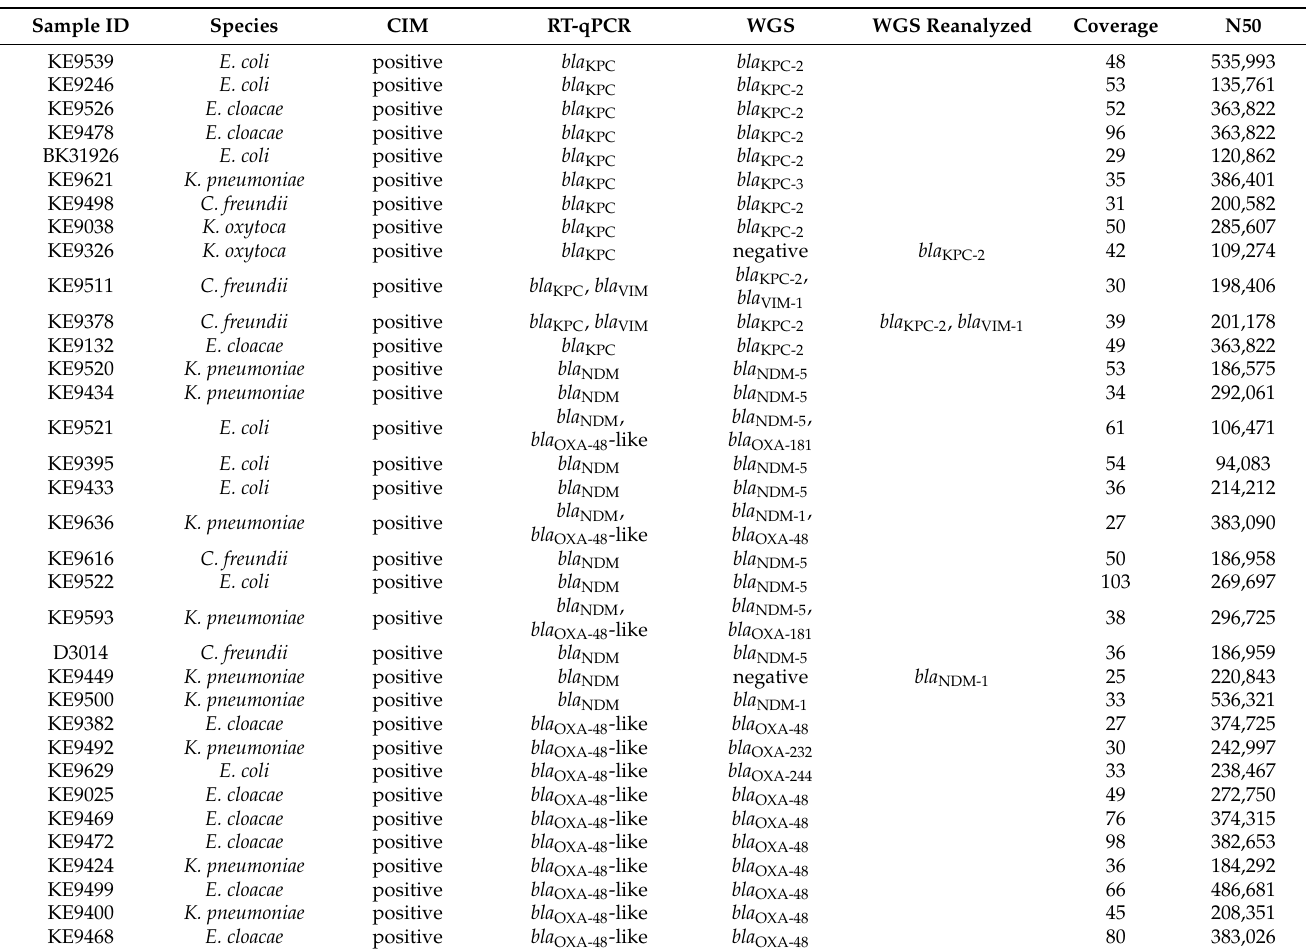
Table A1. Phenotypic carbapenem-resistant Enterobacterales collected in 2019, analyzed by CIM, RT-qPCR and WGS. Quality control parameters for WGS: coverage and